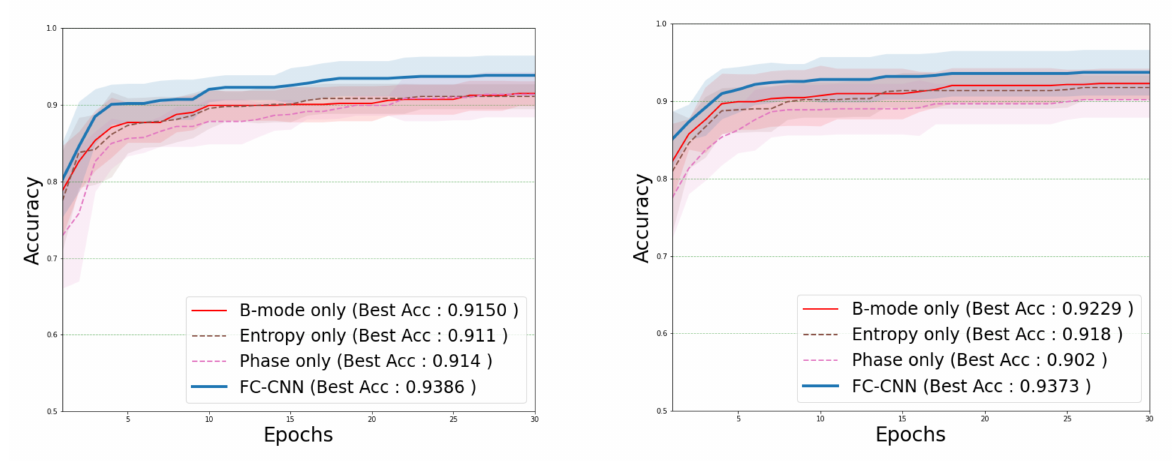
Figure 4. The accuracy curves of the traditional CNN using a single image such as B-mode, entropy, and phase images, and the proposed FC-CNN architectures; ( a ) ResNet-34, ( b ) DenseNet-161. Note that the shaded areas represent the five-fold cross-validation results and the solid lines represent their mean accuracies.